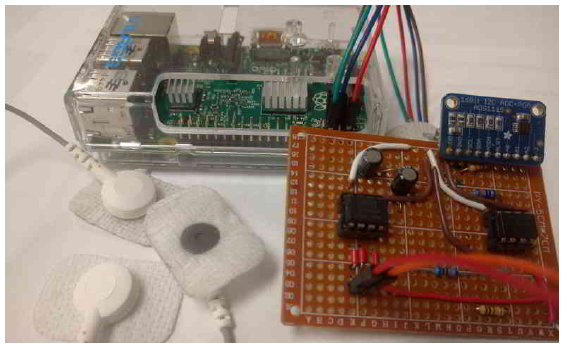
Figure 8. Photo of our experimental setup: electrodes with sensor board in front, the RaspberryPi board at the back.